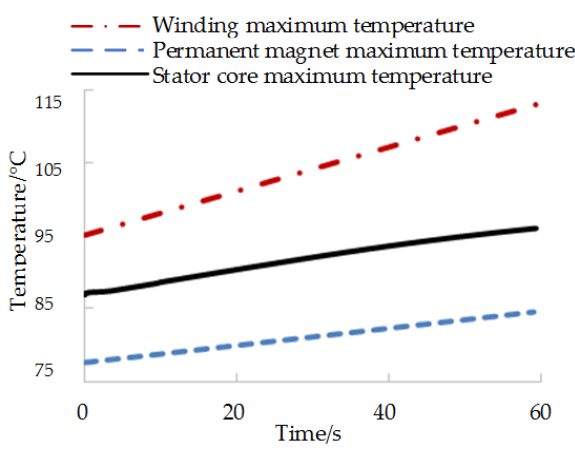
Figure 29. Temperature of main components of the motor changes with time.